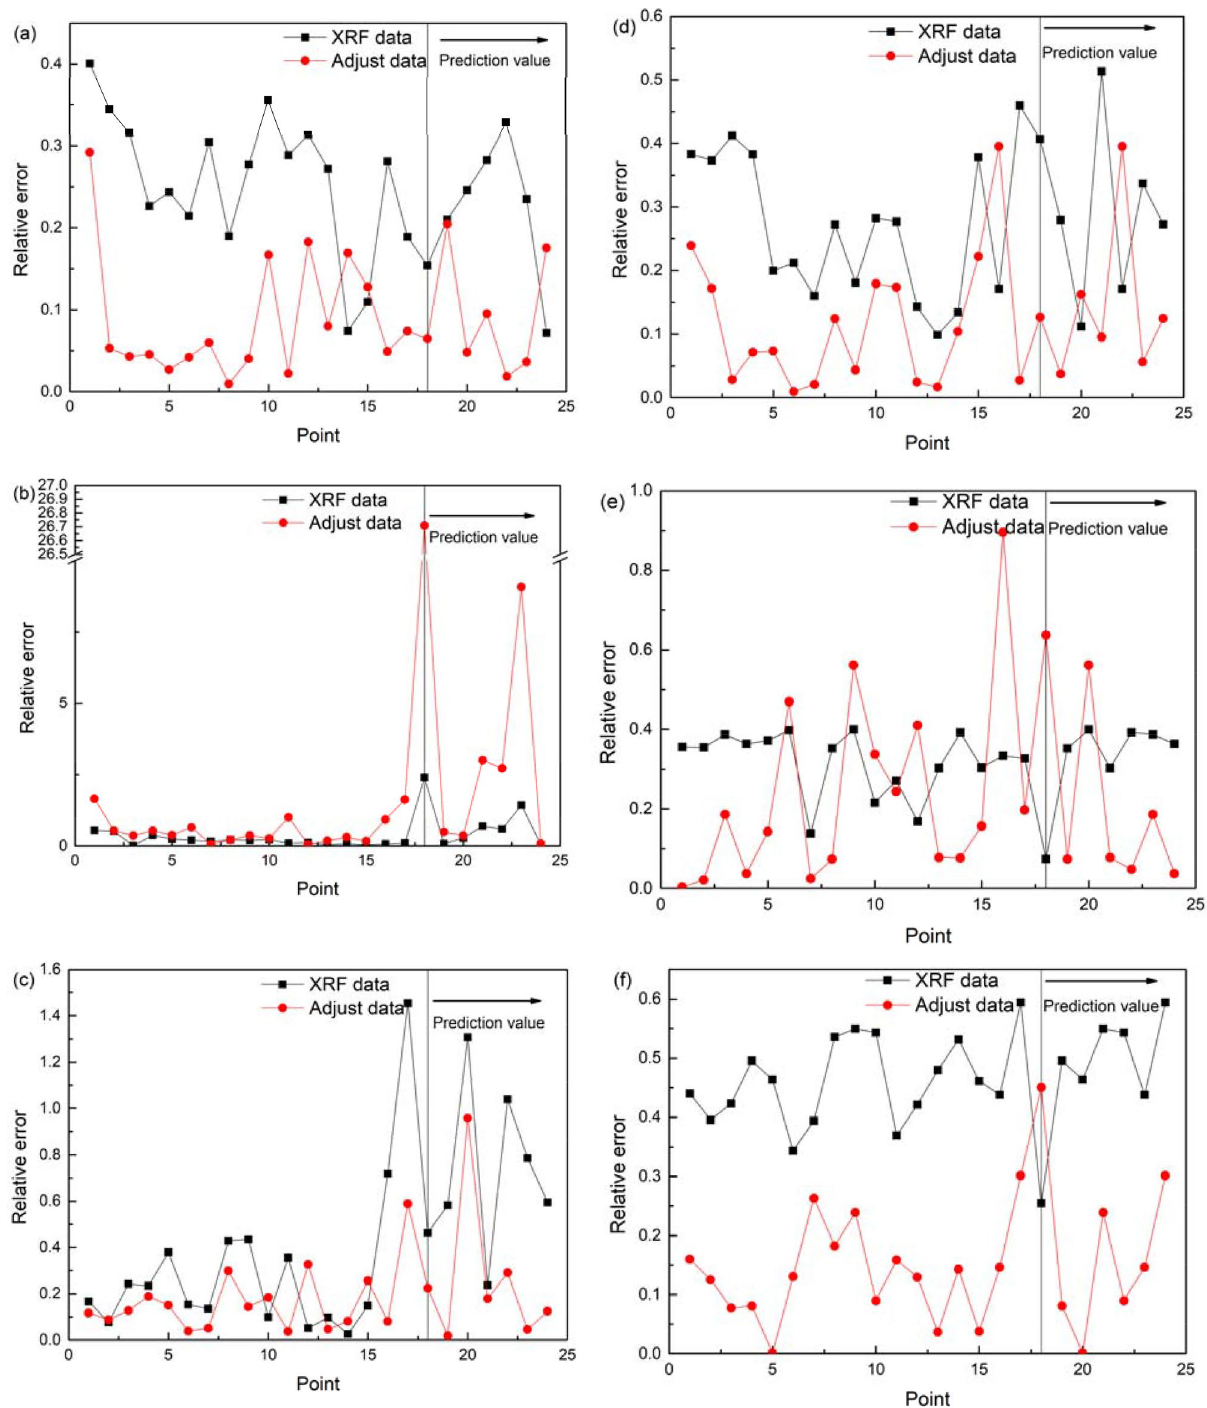
Figure 4. Relative error comparison.